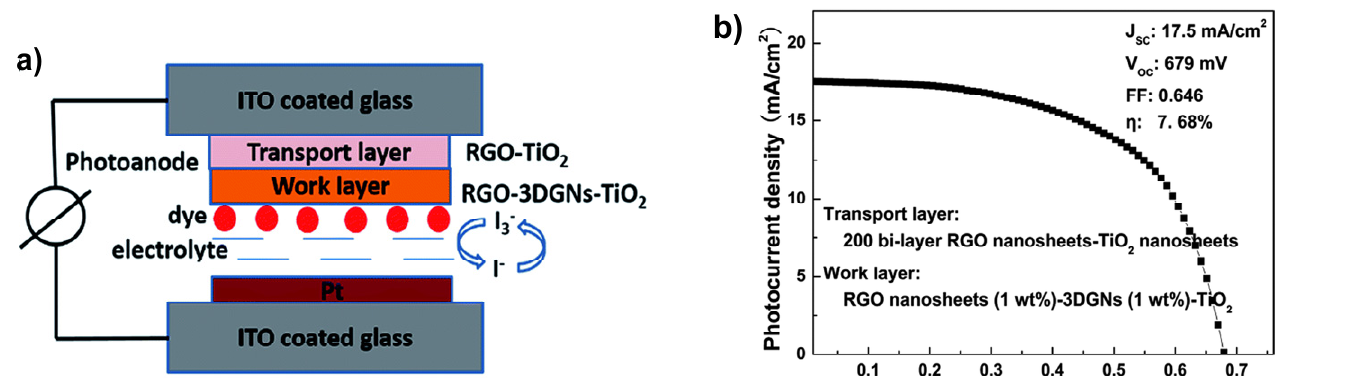
Figure 18. ( a ) DSSC structure; ( b ) J - V characteristic of the device assembled in an optimized manner under standard illumination conditions. Reprinted with permission from ref. [83]. Copyright 2017 The Royal Society of Chemistry.